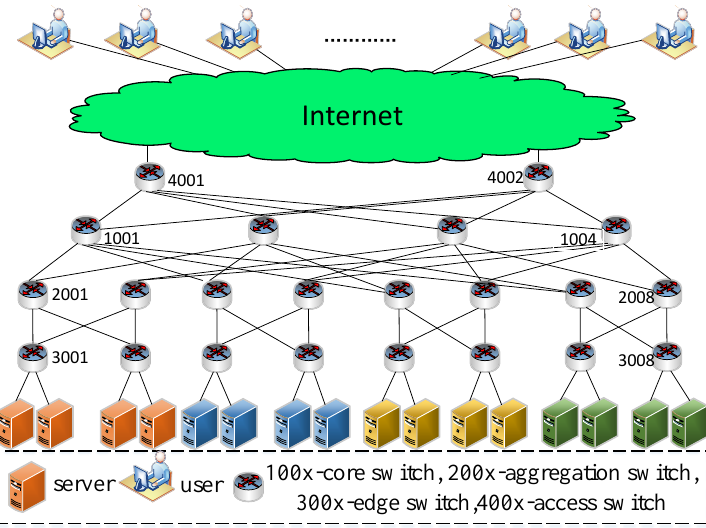
Figure 1. A typical network architecture of Software Defined Data Center